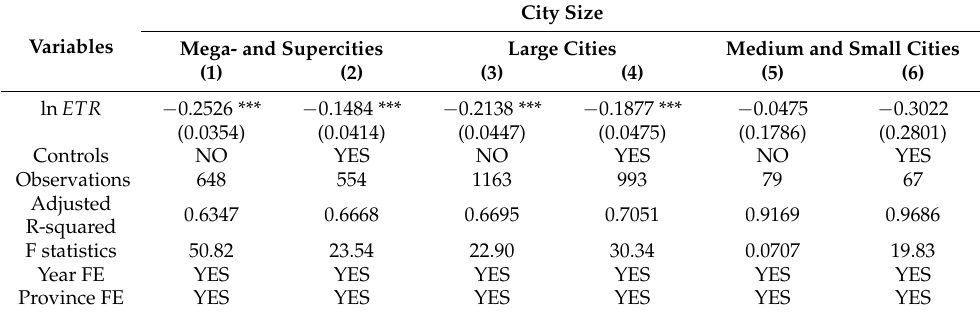
Table 4. Heterogeneity analysis: city